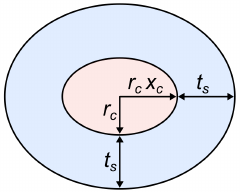
Figure 2. Schematic drawing of the core-shell ellipsoid model used for the calculation of the single particle form factor P ( q